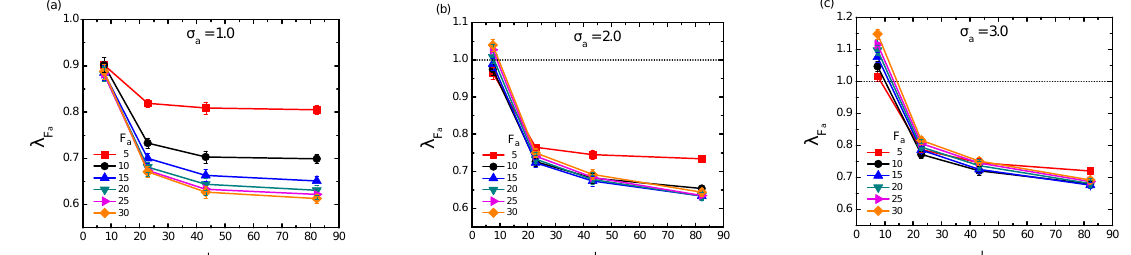
Figure 3. Dependence of scaled gyration radius λ F polymer with different active forces F a , under three typical crowder sizes: σ a = 1.0 ( a ); σ a = 2.0 ( b ); and σ a = 3.0 ( c ). The volume fraction of the crowders is fixed at φ = 0.1. Error bars represent one standard